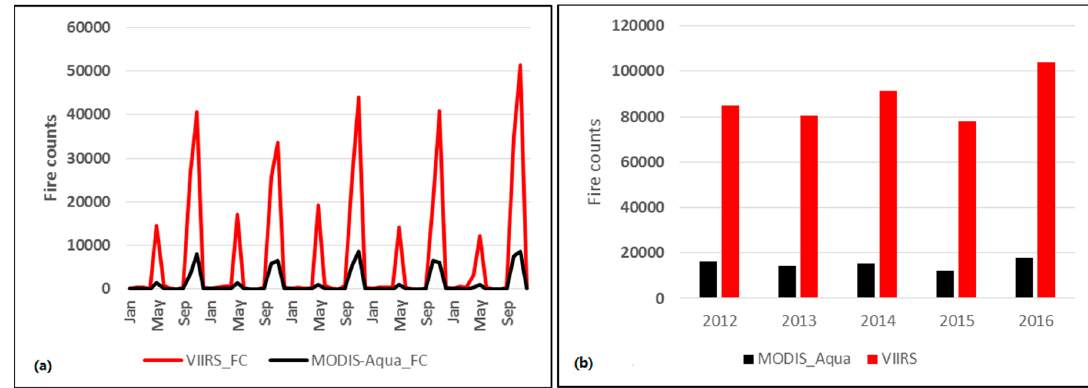
Figure 3. ( a ) Monthly fire counts for Punjab, India derived from VIIRS versus MODIS (AQUA and TERRA combined) data and for different years; ( b ) Averaged across five years, VIIRS detected fires were higher by a factor of 4.8 than MODIS data.